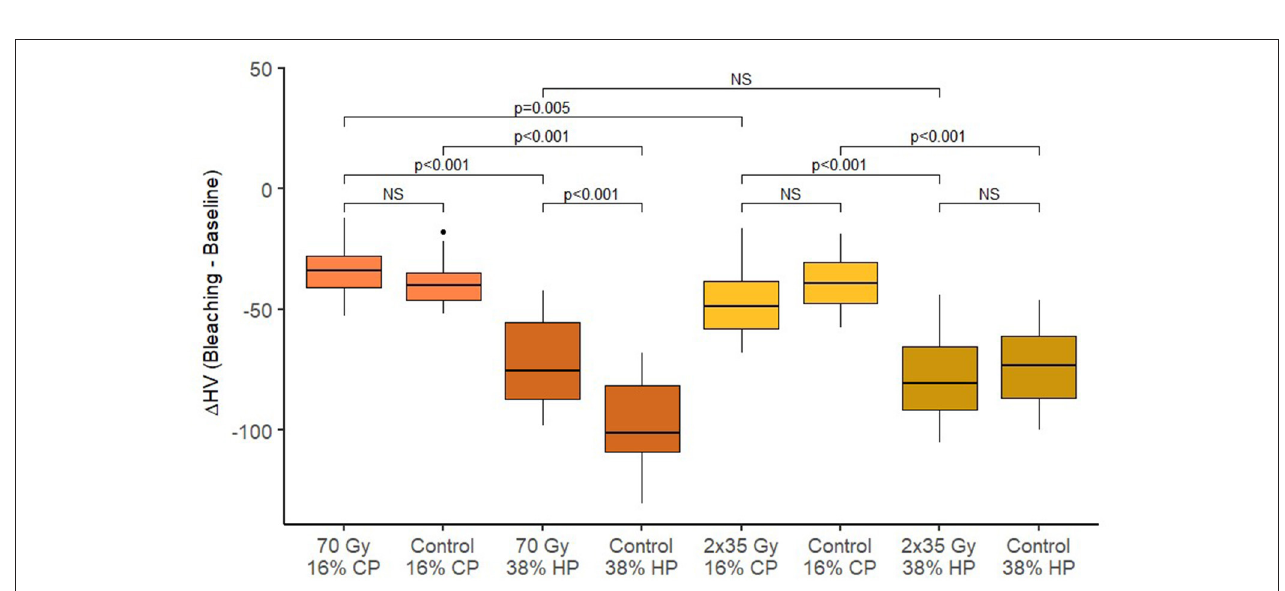
FIGURE 3 | Box-plots of changes in enamel Vickers microhardness after bleaching across different treatment groups.